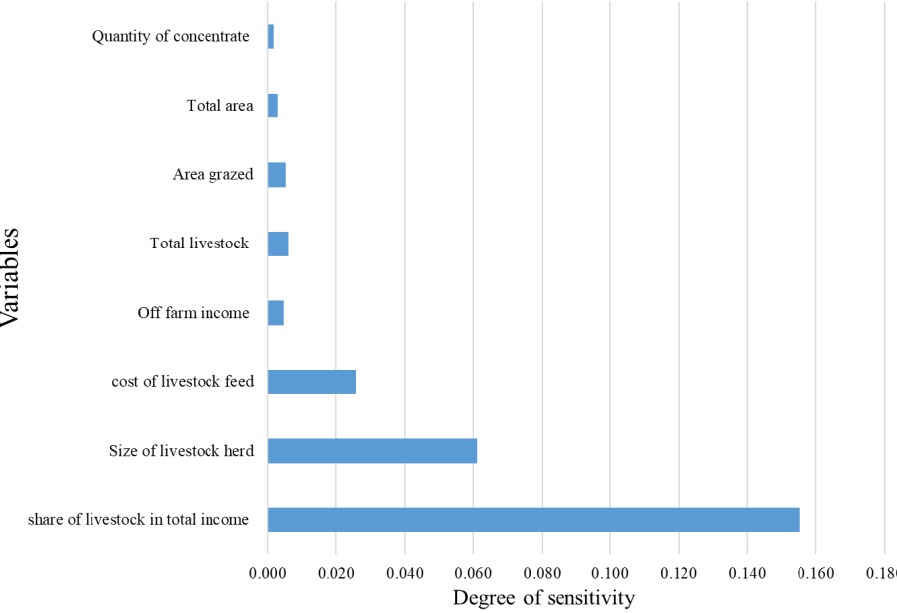
Figure 6. Sensitivity analysis of crop residues left on the soil.